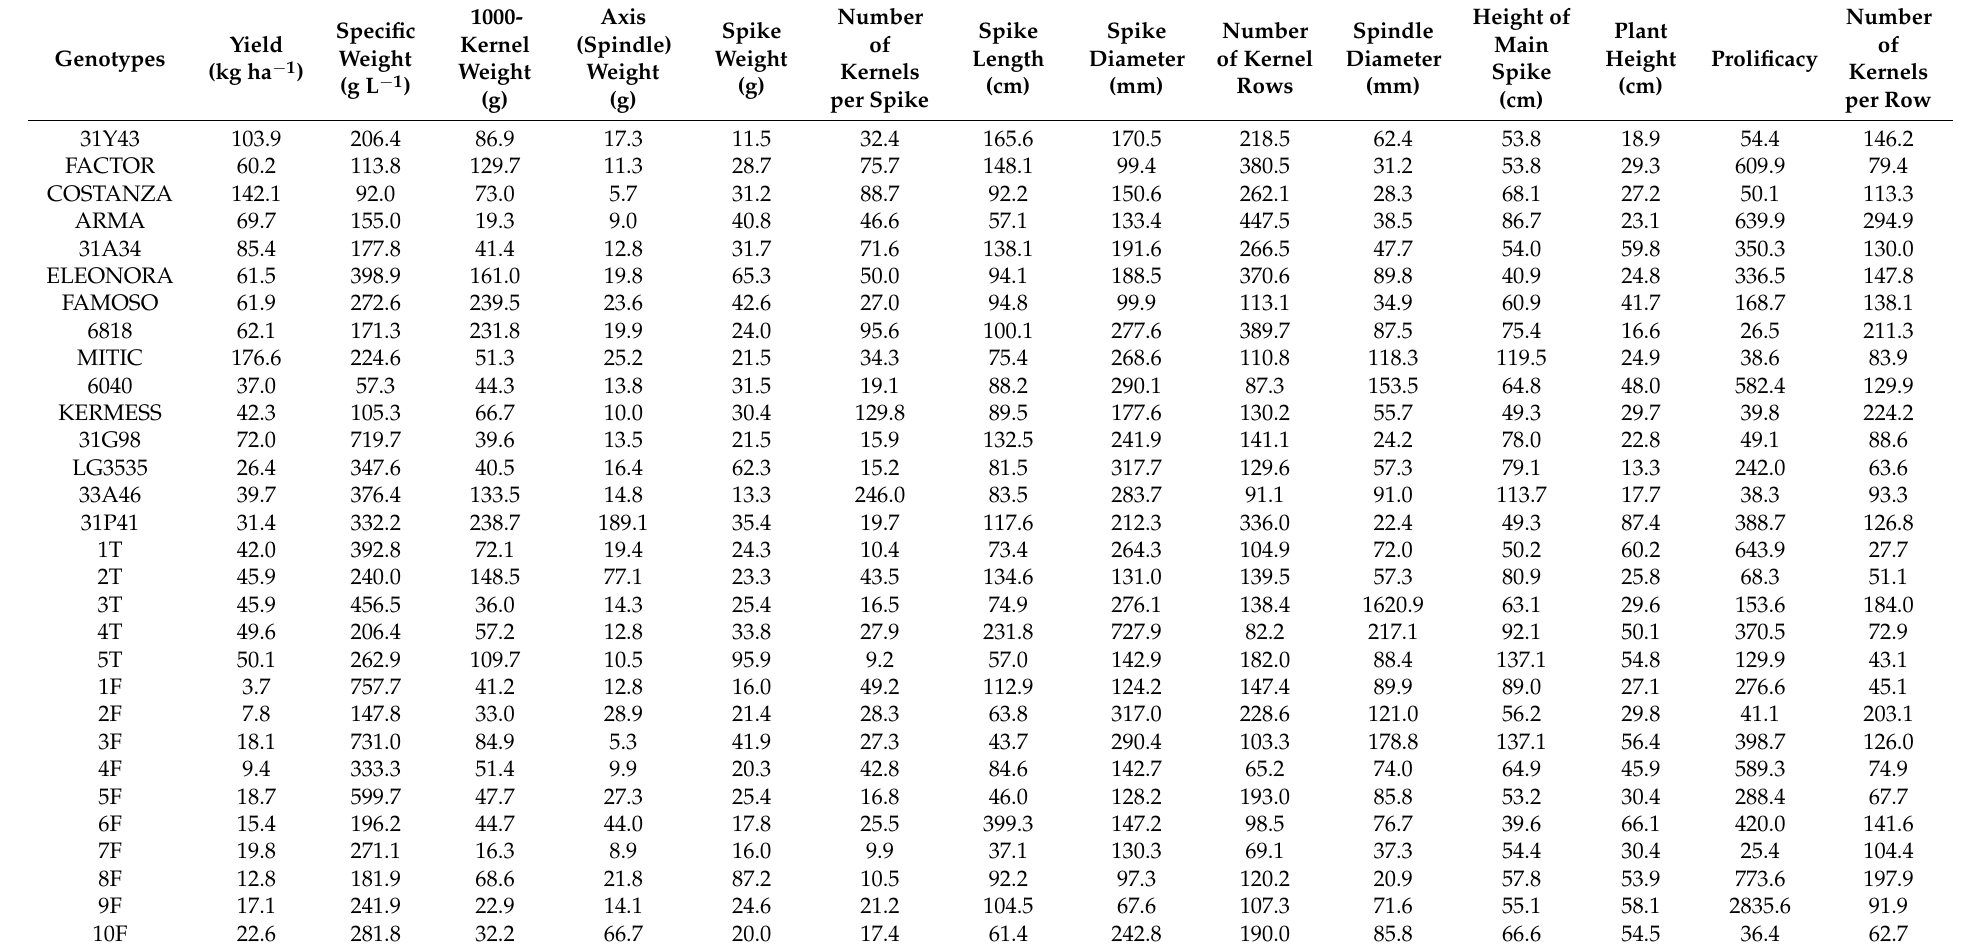
Table 5. Trait stability index ( x / s ) 2 across genotypes and environments for tested traits: yield (kg ha − 1 ), specific weight (g L − 1 ), 1000-kernel weight (g), axis (spindle) weight (g), spike weight (g), number of kernels per spike, spike length (cm) and diameter (mm), number of kernel rows, spindle diameter (mm), main spike and plant height (cm), prolificacy, and number of kernels per row, in Trikala